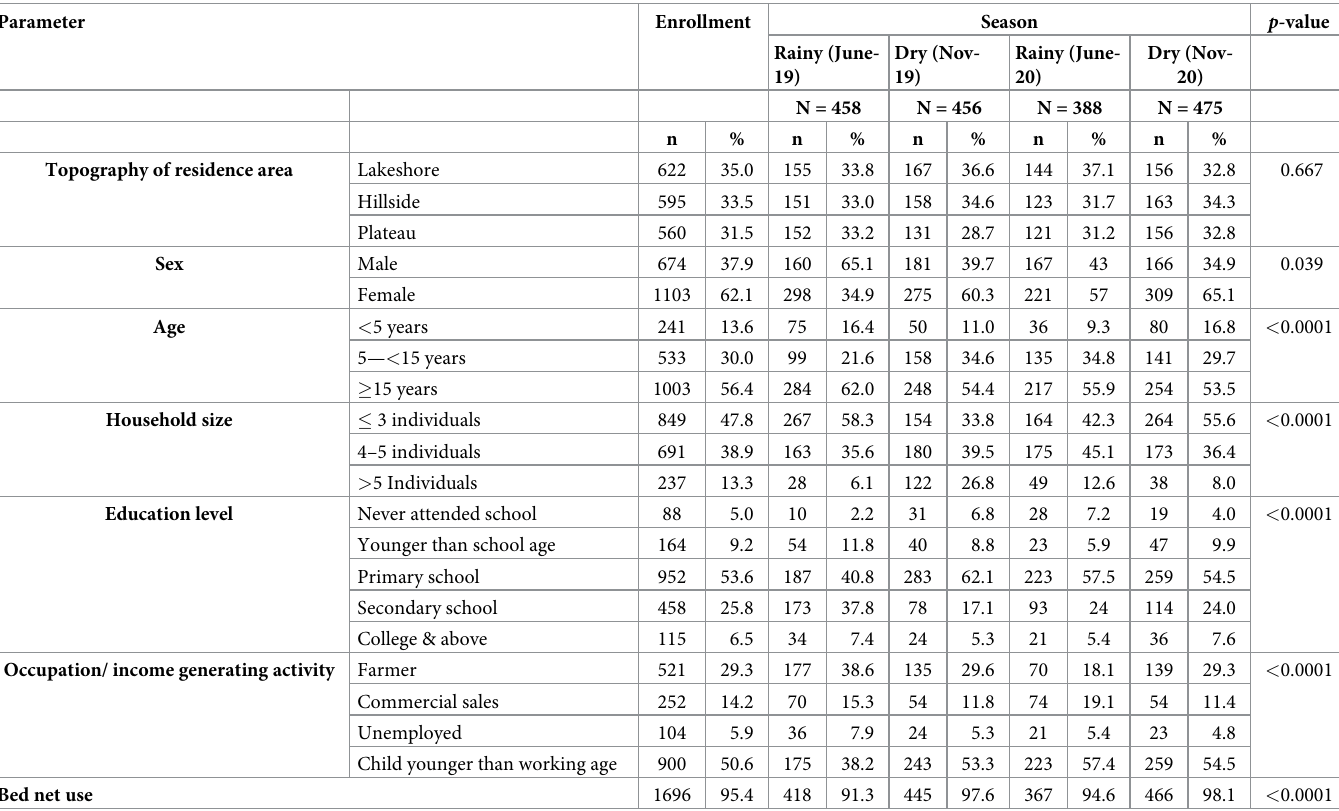
Table 1. Geographic and demographic characteristics of study